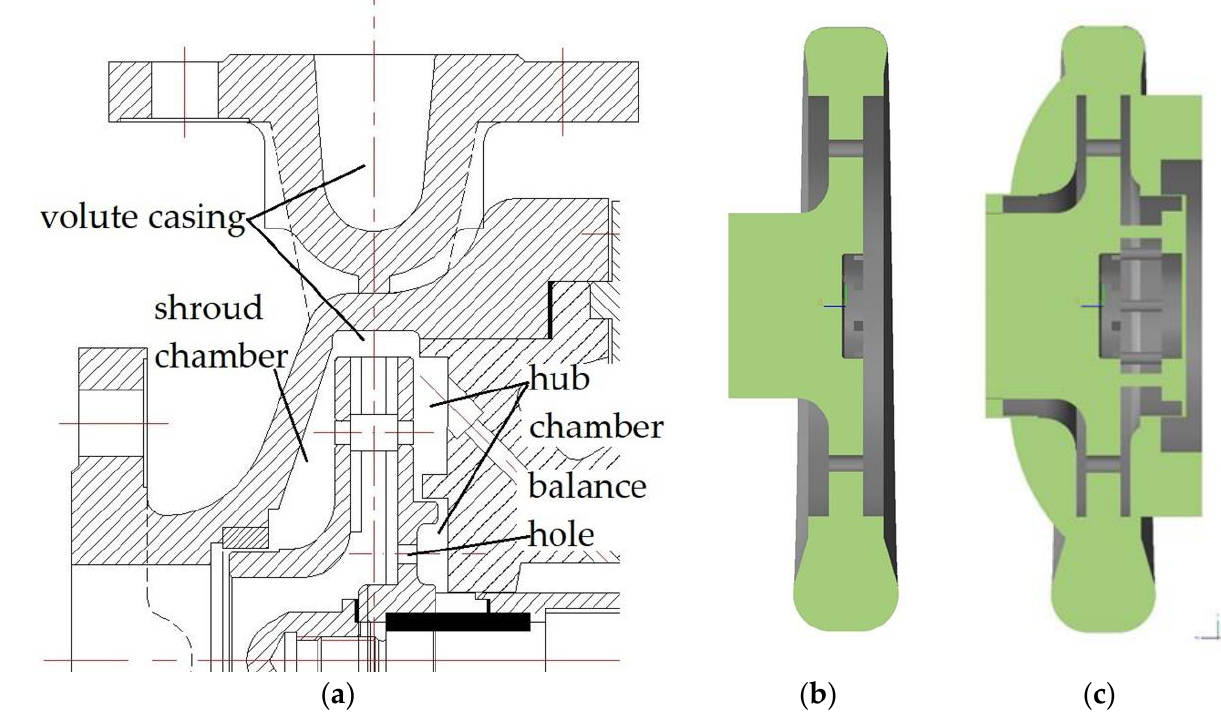
Figure 3. The cross-section diagram ( a ), computational domain without side chambers (hub and shroud chamber) and balance hole ( b ) vs. computational domain with side chambers (hub and shroud chamber) and balance hole ( c ).